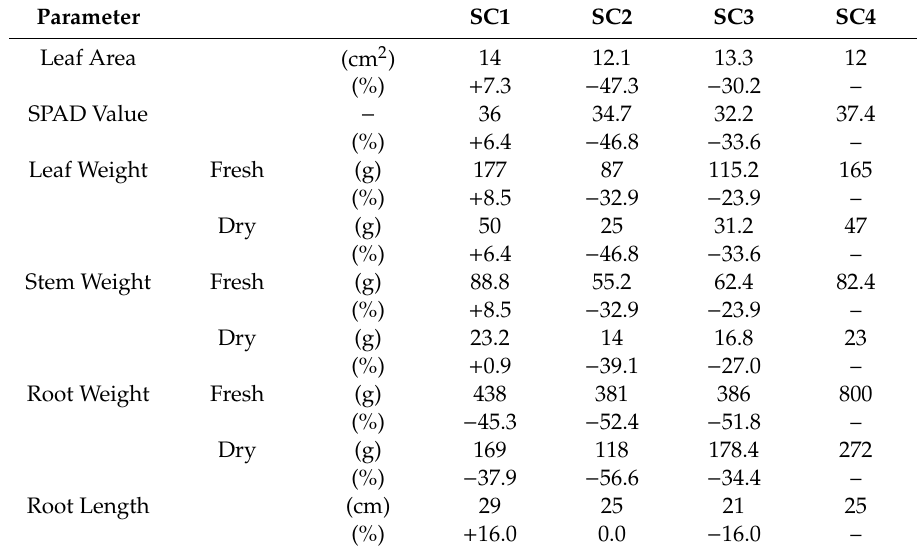
Table 3. Mean values of the main biometric parameters of sage plants, calculated for the four Substrate Compositions (SC). The percentage values ( +/ − ) are computed for each SC with reference to SC4. Parameter